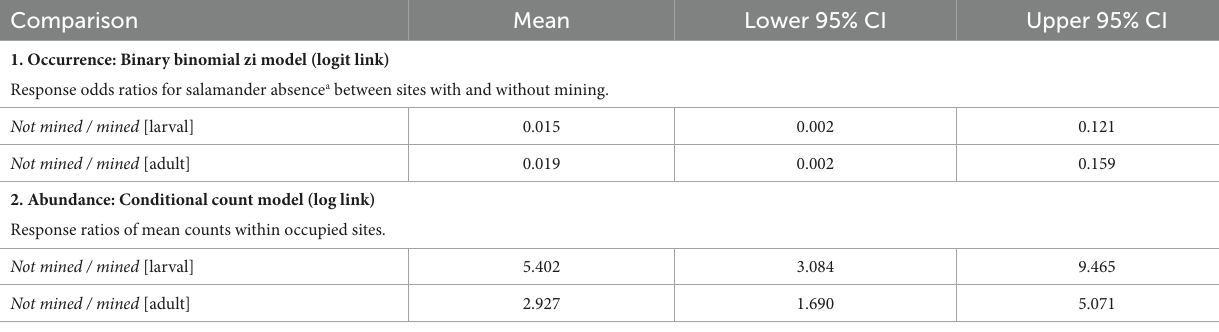
TABLE 4 Example for the numerical presentation of differences between factor levels.